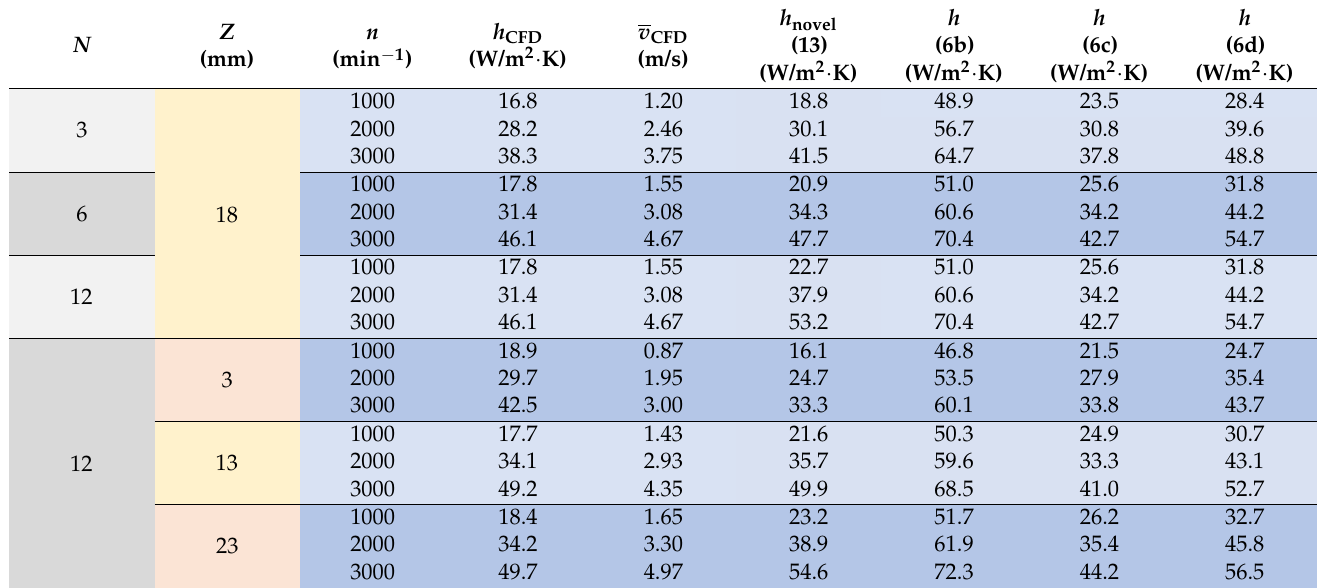
Table 8. Comparison between novel approach and reference equations for calculating HTC compared to CFD simulation results ( R = 26